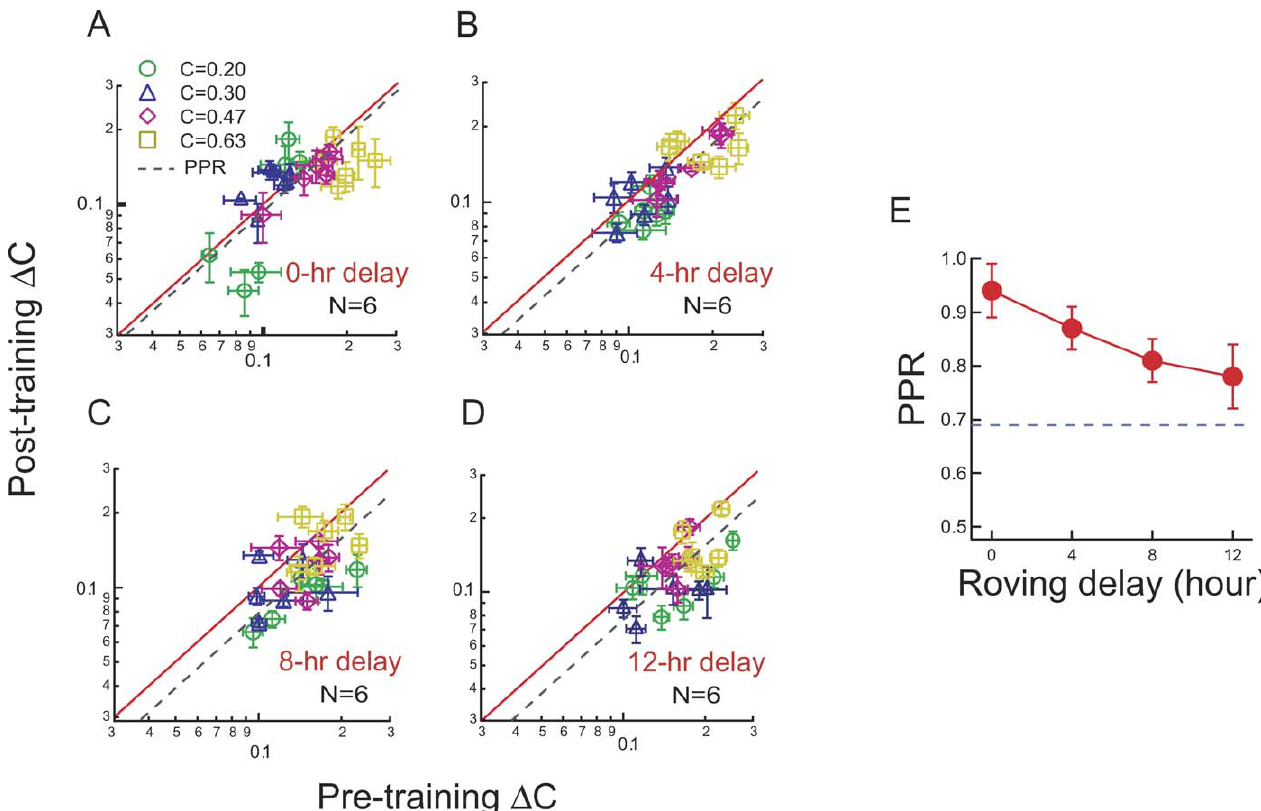
Figure 2. The Effects of Roving After Each Training Session on Perceptual Learning (A–D) Post- versus pre-training contrast thresholds in practice conditions in which each regular temporal-patterned training session was followed by roving interference after a delay of (A) 0 h ( F 1,5 ¼ 1.48, p ¼ 0.278), (B) 4 h ( F 1,5 ¼ 10.6, p ¼ 0.022), (C) 8 h ( F 1,5 ¼ 42.0, p ¼ 0.001), and (D) 12 h (F 1,5 ¼ 13.1, p ¼ 0.015). (E) PPR as a function of the delay of roving interference. The horizontal line indicates the PPR in regular temporal-patterned training without followed roving interference (Figure